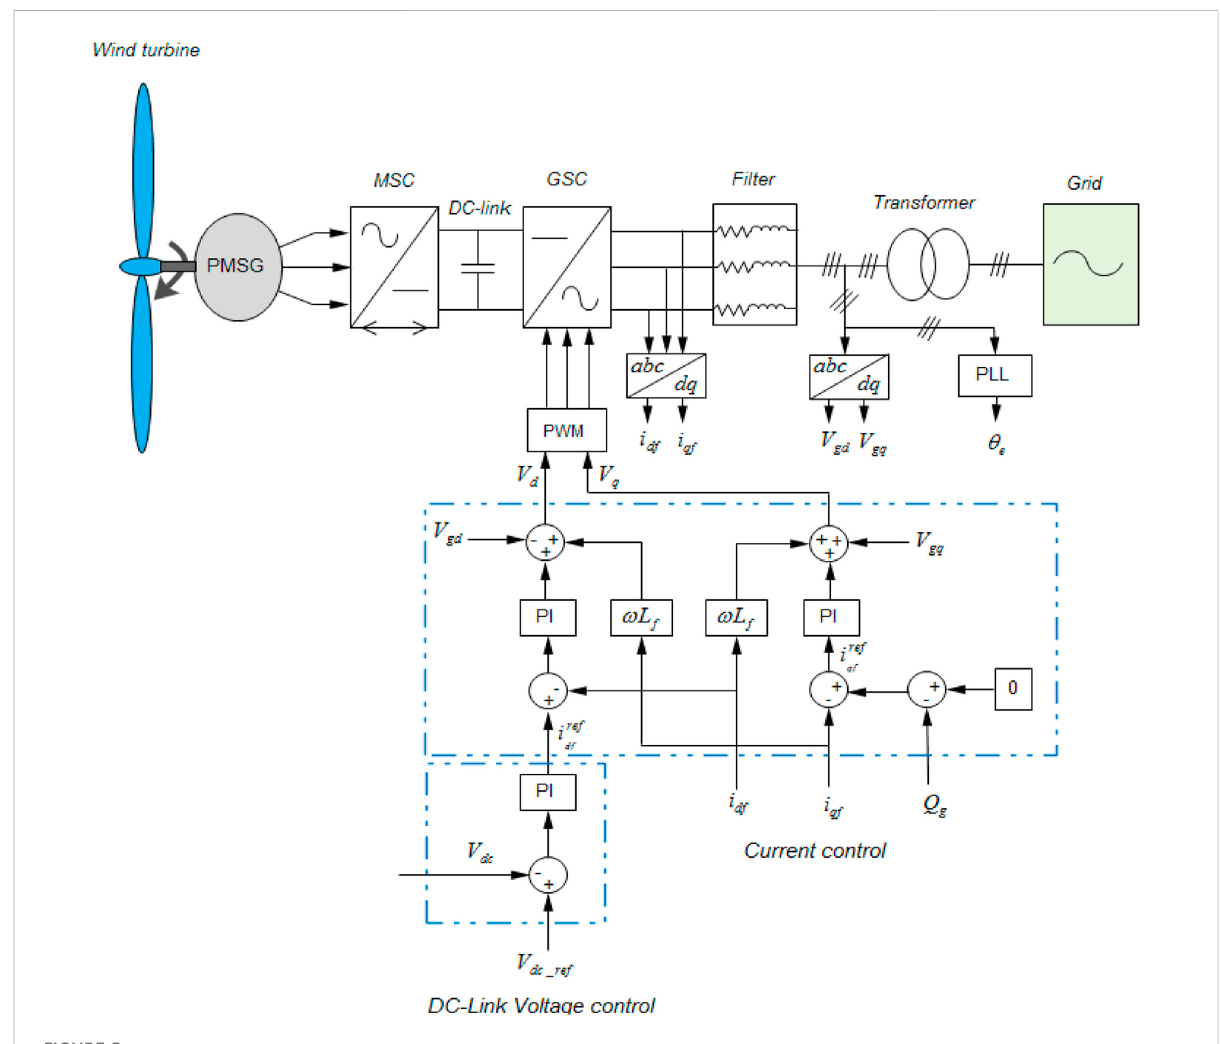
FIGURE 5 GSC PI controller